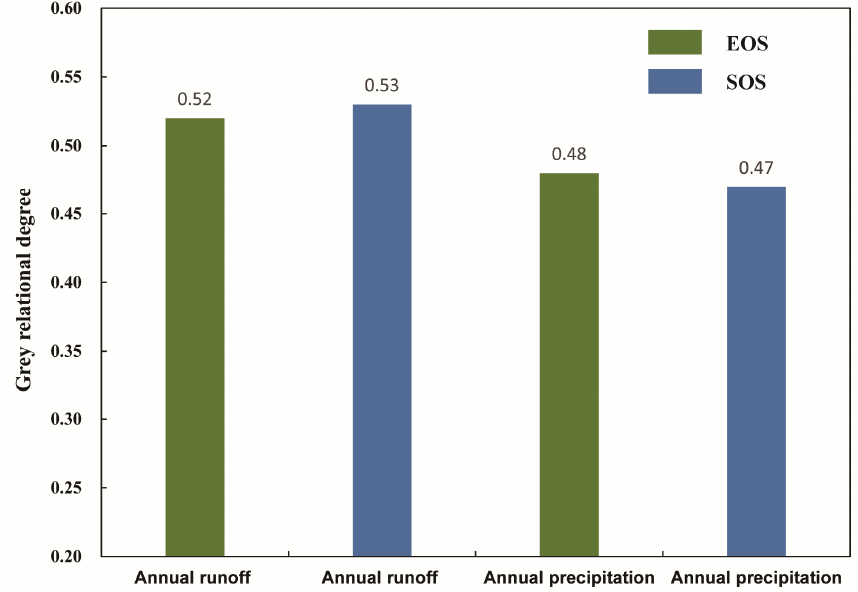
Figure 9. Grey relational analysis between phenology (SOS and EOS) and water (annual runoff and annual precipitation).